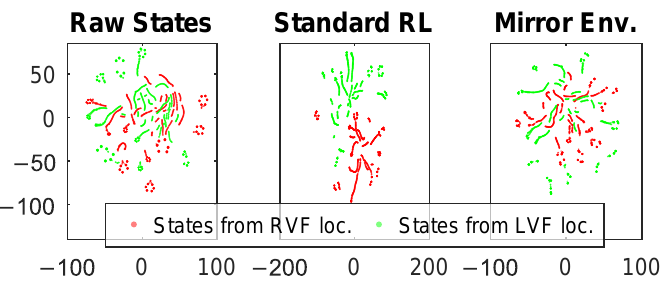
Figure 6. Manifold representation of the learned features by different agents. Inter-fold similarity was better retained in features of the proposed